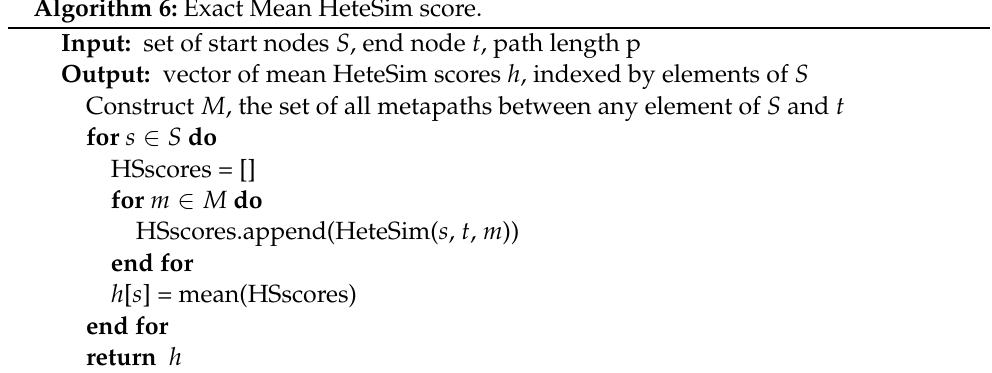
Algorithm 6: Exact Mean HeteSim